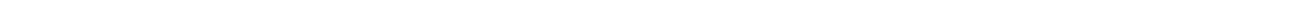
Fig. 1 MT1-MMP-dependent pericellular collagenolysis is an adaptive response to matrix porosity. a MDA-MB-231 cells were embedded in 2.0 mg/ml fl uorescent type I collagen (cyan) and polymerization was induced at neutral pH at 37 °C. Cells were fi xed after 2.5 hrs and stained for cleaved collagen neoepitope (Col1- 3 ⁄ 4 C antibody, red), α -tubulin (green) and DAPI (blue). Dashed box indicates the region used for line-scan analysis in panel b with yellow, orange and pink dots indicating nucleus center, posterior and anterior limits of regions used for line-scan analysis. Dashed lines indicate initial cell position (thick) and cell rear (thin), respectively. Inset shows nucleus and cleaved collagen signal and arrowheads point to nucleo-anterior collagenolysis. b Averaged maximal fl uorescence intensity pro fi les of cleaved collagen in 37 °C (orange curve) or 20 °C (purple curve) polymerized collagen±SD (left Y - axis) and DAPI (right Y -axis) along cell axis. n , number of cells used to calculate averaged intensity pro fi les from three independent experiments; “ 0 ”